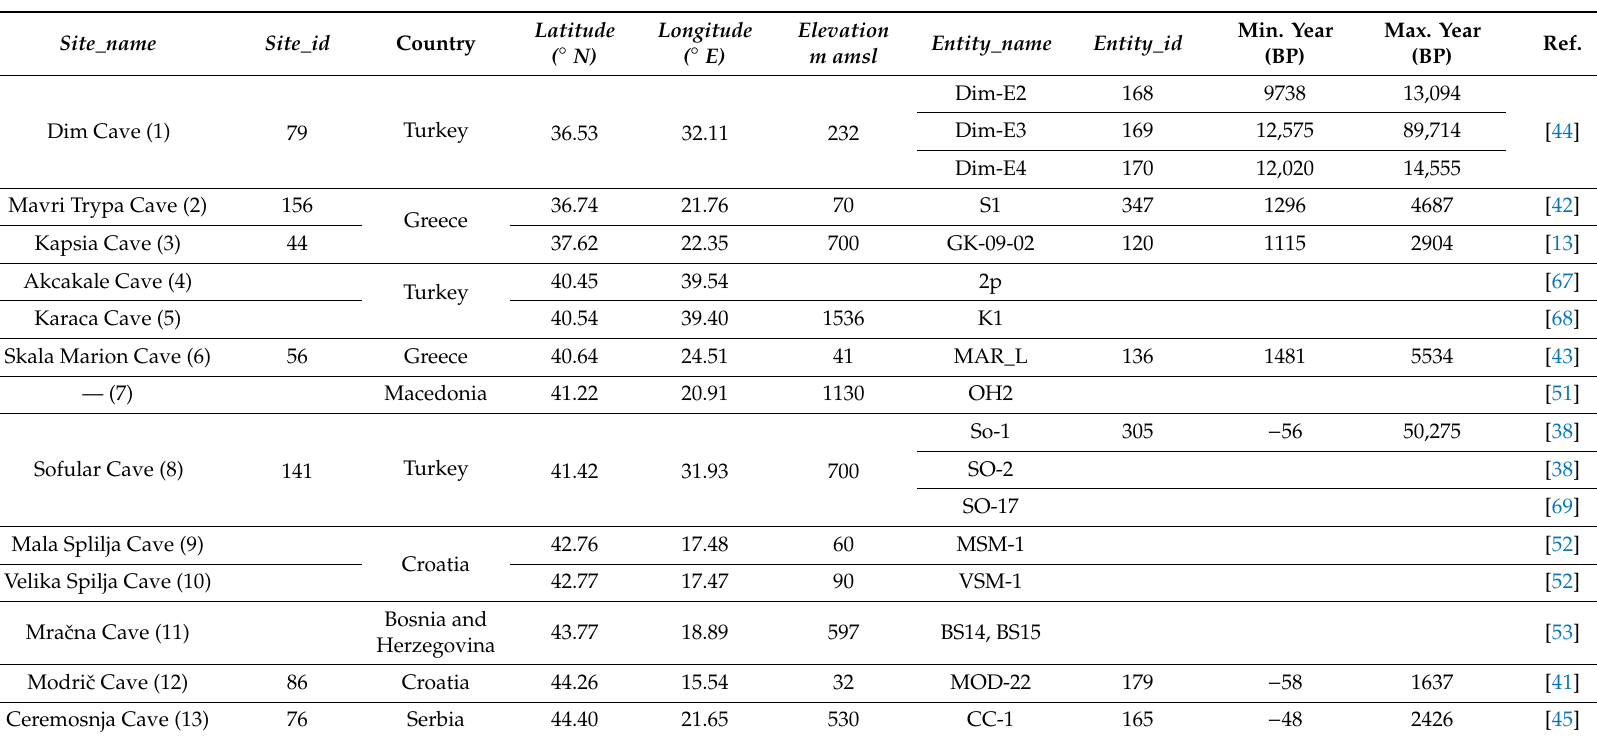
Table 1. Metadata of the speleothem records from the Eastern part of Europe and Turkey. Column headings in italics represent field names that can be queried in the SISAL database. The numbers in parentheses next to the site names identify the site locations in Figure 1. Min / Max year correspond to the last / first ages of stable isotope data, respectively. BP is defined as years before present, where present is 1950 CE. Minimum and maximum age of stable isotope records were rounded to integer. Speleothems without an entity_id are not in SISAL_v1